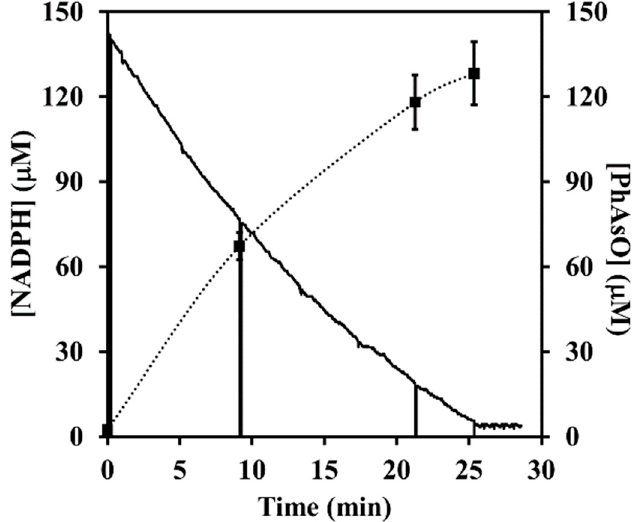
Figure 4. Time courses of NADPH consumption and arsenous product accumulation. The reaction mixture initially contained 142 µ M NADPH, 50 µ M FMN, 159 µ M PhAsO(OH) 2 and 9 nM ArsH in 0.1 M sodium phosphate buffer (pH 7.0, 30 °C). Oxidation of NADH was continuously monitored at 340 nm (solid line) while samples were taken for HPLC analysis of the phenylarsonous acid levels (points lying on the dotted line). Vertical bars denote standard deviations from triplicate samples.